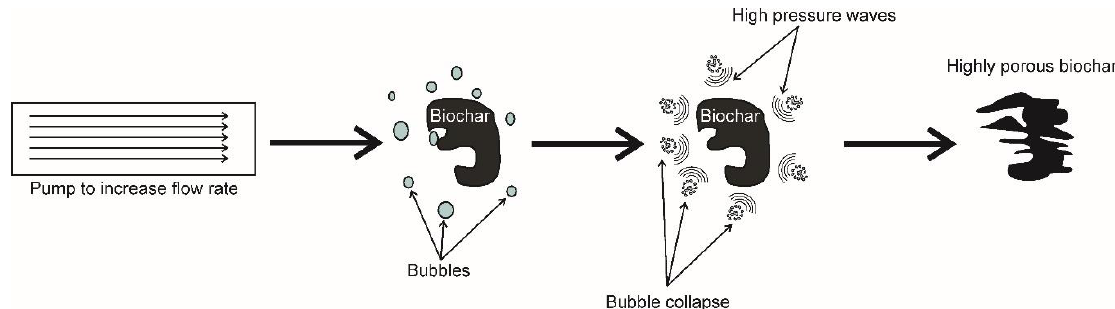
Figure 11. Scheme of the hydrodynamic cavitation method with a pump directing the water flow towards the biochar.